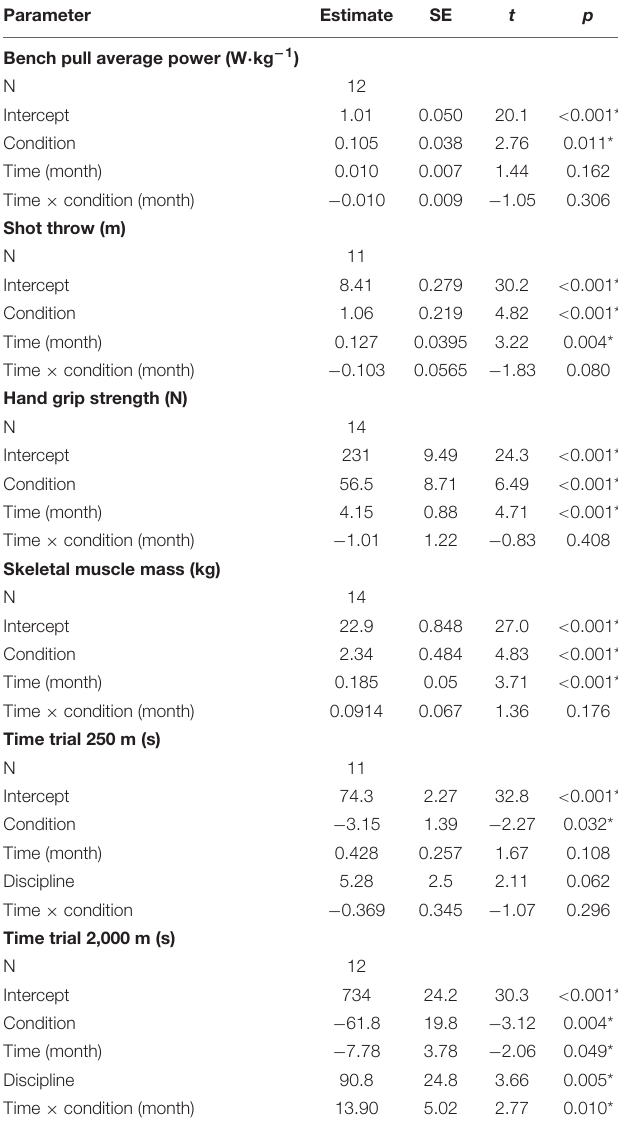
TABLE 3 | Linear mixed-effects models for within-subject analyses. Parameter Estimate